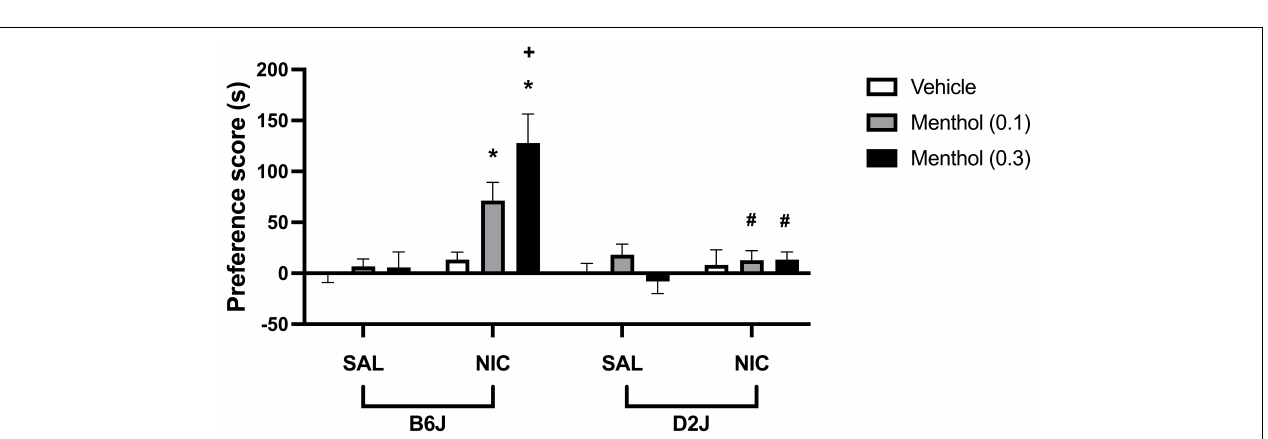
FIGURE 6 | Effects of menthol on nicotine CPP in adult C57BL/6J and DBA/2J mice. Adult male and female mice were conditioned with either saline or nicotine (0.1 mg/kg, s.c.) for 3 days in the CPP paradigm. On each conditioning day, mice were pretreated with menthol (0.1 or 0.3 mg/kg, i.p.) or its vehicle (1:1:18) 30 min before nicotine or saline injection. Data are presented as the mean ± SEM of 10 mice/genotype/group. Results are based on an ordinary three-way ANOVA with strain, nicotine treatment, and menthol treatment as factors. * P < 0.05 vs. saline/veh, + P < 0.05 vs. nicotine/veh and # P < 0.05 vs. B6J. sal, saline; nic,